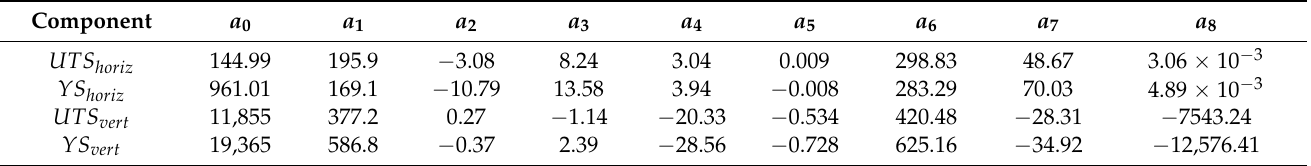
Table 5. Calculated coefficients for the linear regression models of horizontal and vertical components of UTS and YS in